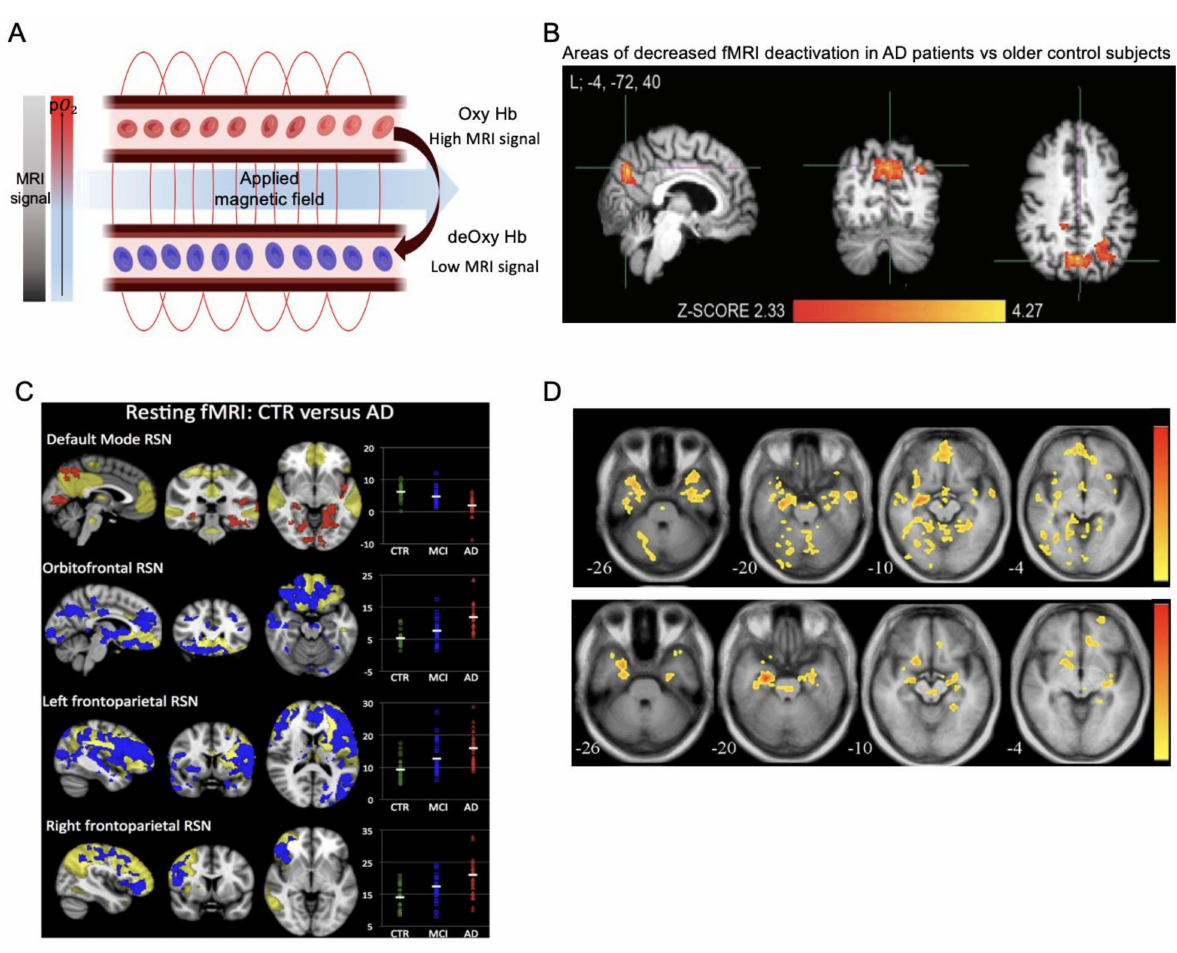
Figure 4. fMRI imaging. ( A ) BOLD effect in MRI. ( B ) Areas of decreased fMRI task-induced deac- tivation in posteromedial cortical areas in patients with AD compared to older controls. Adapted from [67] with permission from Hindawi. ( C ) Spatial maps of resting-state networks (RSNs, trans- parent yellow) overlaid with clusters showing significantly lower (red) or higher (blue) functional connectivity in AD compared to control subjects (CTR). Adapted from [76] with permission from BMJ Publishing Group Ltd. ( D ) Right hippocampal connectivity maps in the healthy age-matched control group (top row) and AD group (bottom row). Adapted from [77] with permission from